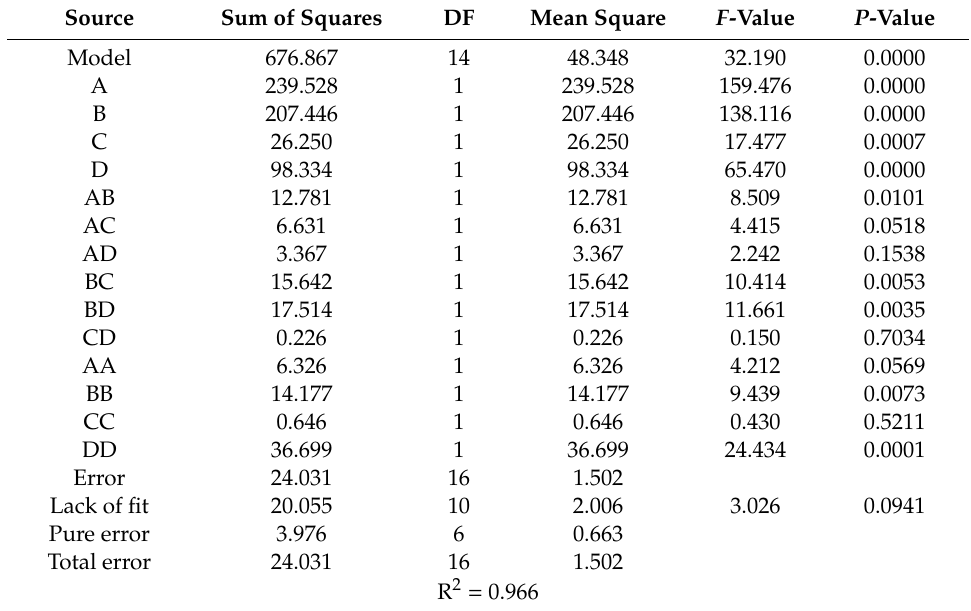
Table 2. Analysis of variance table for response surface quadratic